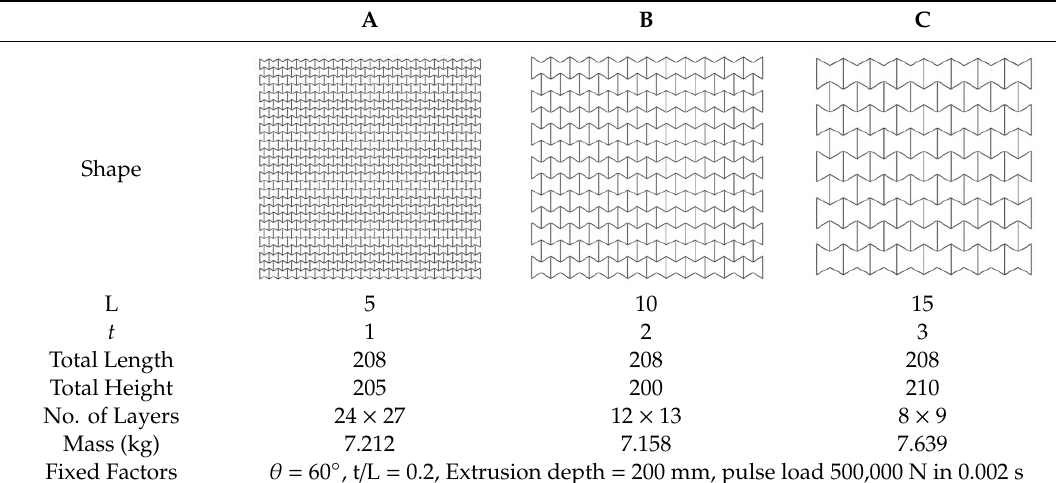
Table 5. Auxetic cores with three different cell dimensions and their properties.